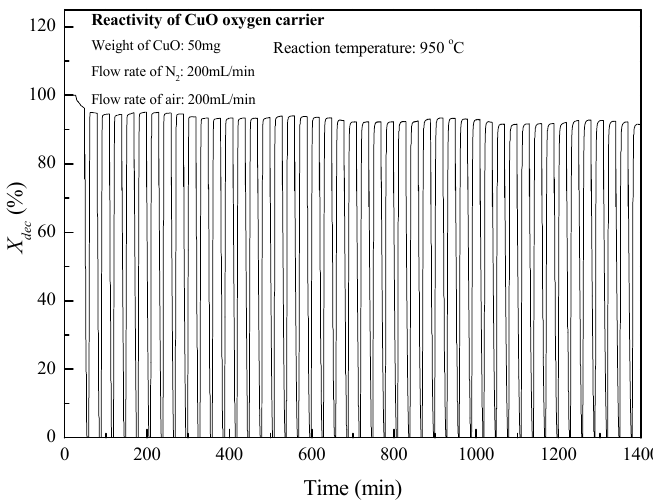
Figure 1. Conversion for the oxygen uncoupling of CuO in the TGA during various redox cycles under nitrogen atmosphere at 950 °C.